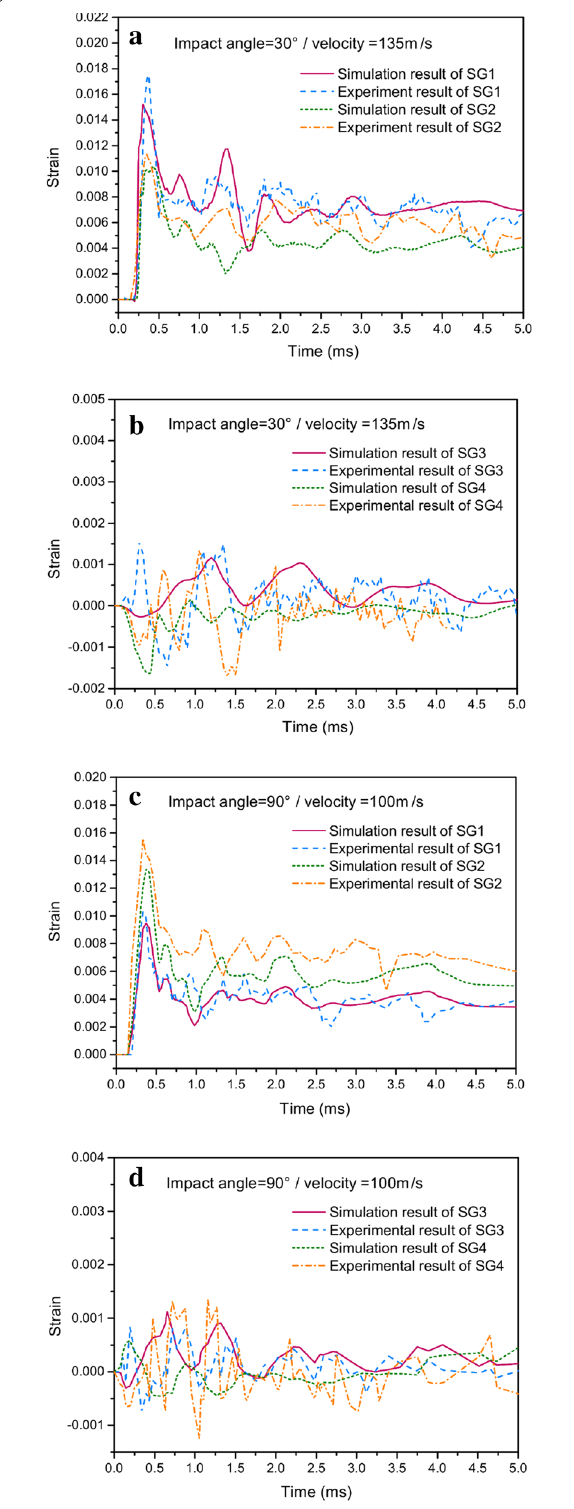
Figure 6 Comparisons of simulation and experimental results: ( a ) impact angle 30°, velocity 135 m/s (SG1-2), ( b ) impact angle 30°, = = = velocity 135 m/s (SG3-4), ( c ) impact angle 90°, velocity 100 m/s = = = (SG1-2) and ( d ) impact angle 90°, velocity 100 m/s = =